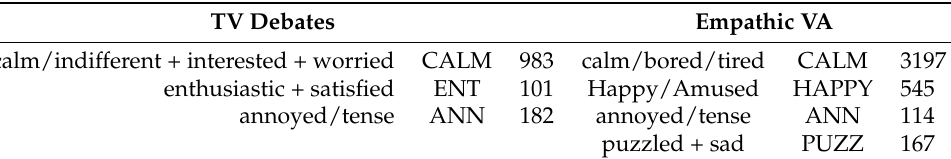
Table 6. Composition of the final categories of each corpus with the number of samples that each category